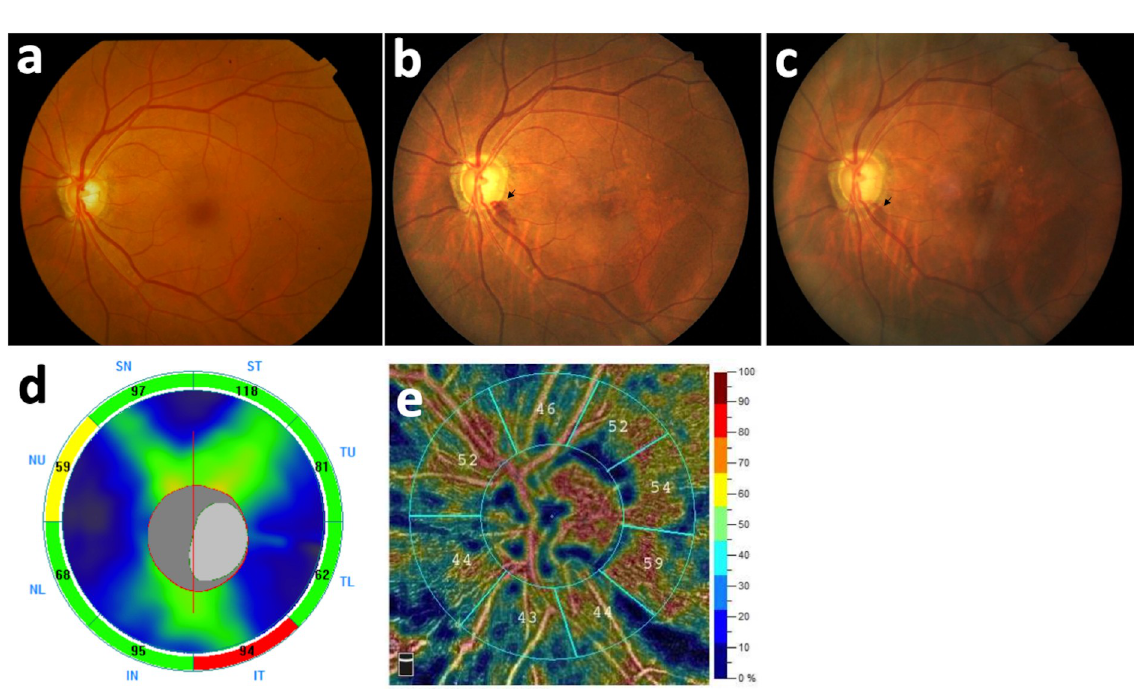
Fig 3. A 67-year-old woman with peripapillary pigmentation following resolution of DH after a 2-year follow-up. (a) Disc photography before DH. (b) Peripapillary DH (arrow) developed at a 5 o’clock position. (c) 2 years later, pigment formation (arrow) at prior site after the resolution of DH. (d) & (e) In final visit, optical coherence tomography and angiography revealed RNFL thinning and decreased VD in the superotemporal area corresponding to findings on a color fundus photo. https://doi.org/10.1371/journal.pone.0237796.g003 PLOS ONE | https://doi.org/10.1371/journal.pone.0237796 August 17,